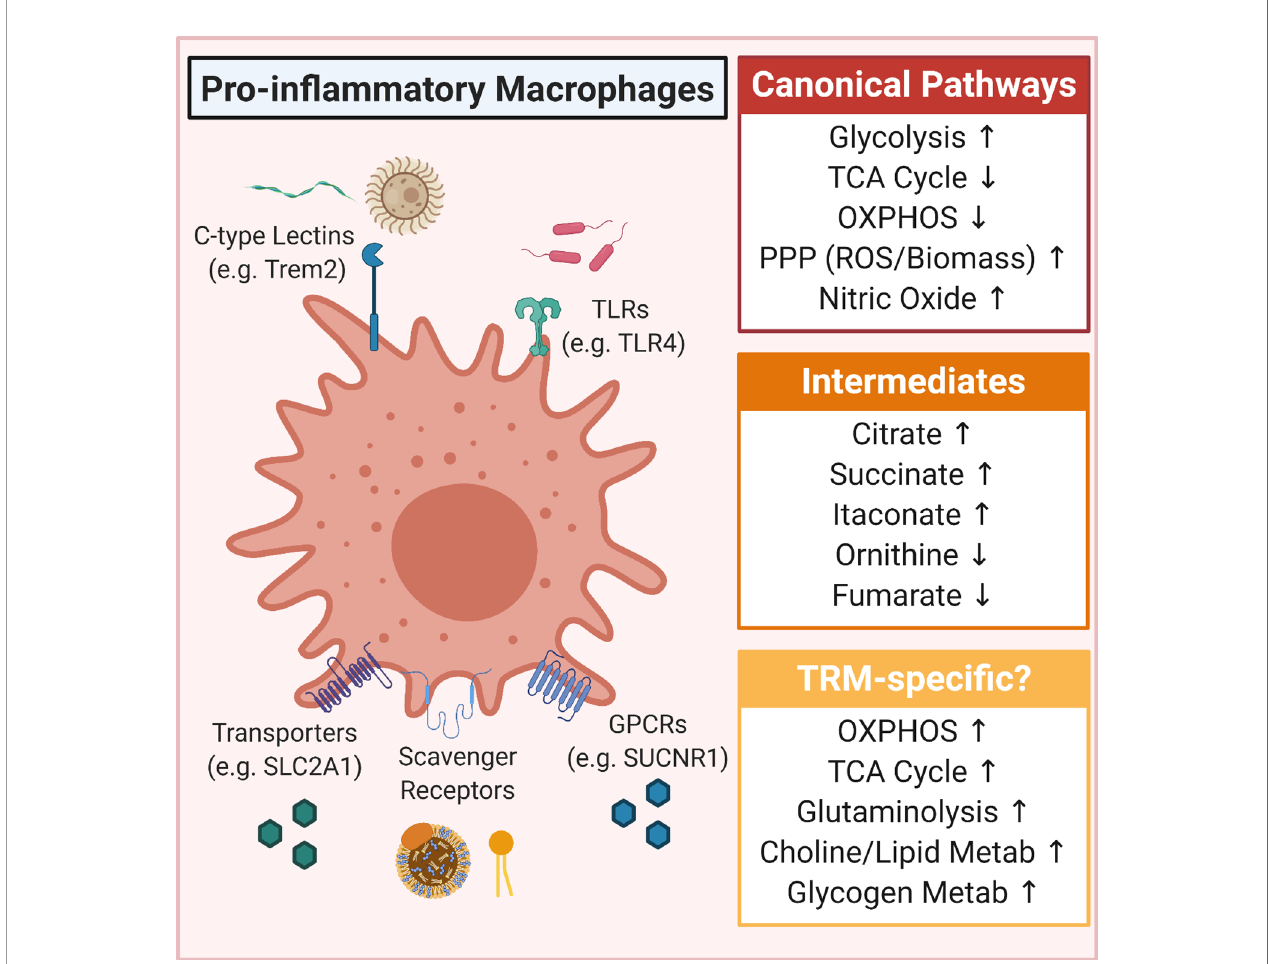
FIGURE 1 | Overview of metabolic pathways induced in pro-in fl ammatory macrophages. Shown is the canonical pro-in fl ammatory macrophage metabolic program (Canonical Pathways) as well as some of the more predominantly de fi ned intermediates that accumulate in pro-in fl ammatory macrophages (Intermediates). Also included are some tissue-resident macrophage (TRM)-speci fi c metabolism observations, including that TRMs in some tissues upregulate OXPHOS and glutaminolysis, that lipids (such as oxidized phosphoplipids and high/low-density lipoproteins) can drive a hyper-metabolic state, and in some contexts, glucose is shunted into